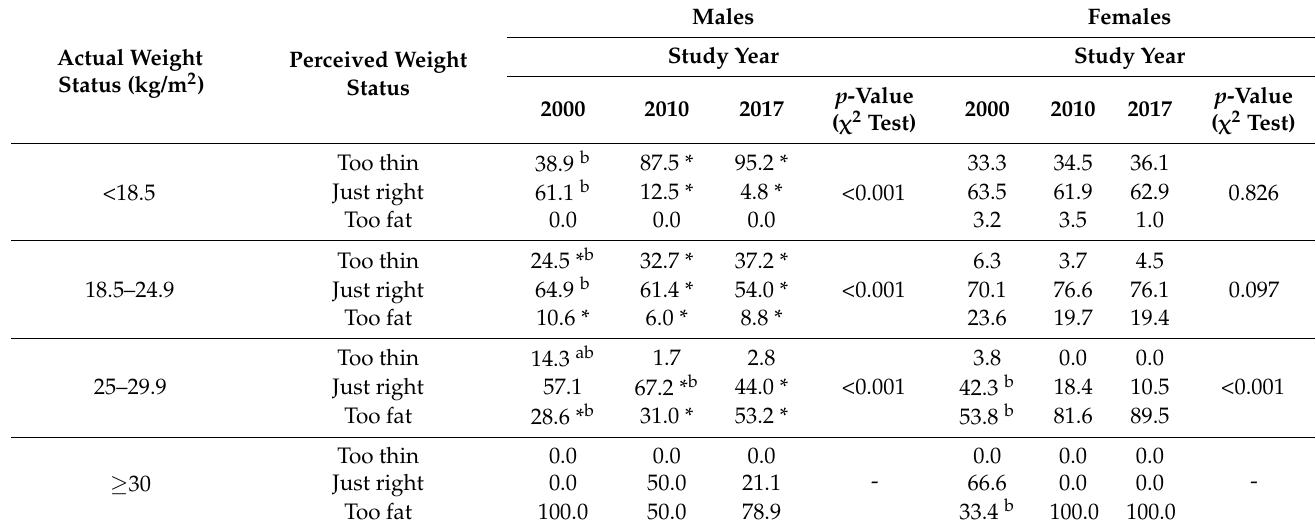
Table 3. Distribution (%) of students by weight perception, according to actual weight status, in 2000, 2010 and 2017.